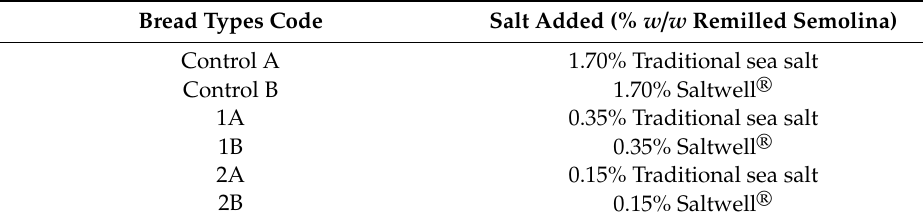
Table 1. Bread type code and percentage of two salts on remilled semolina basis. Bread Types